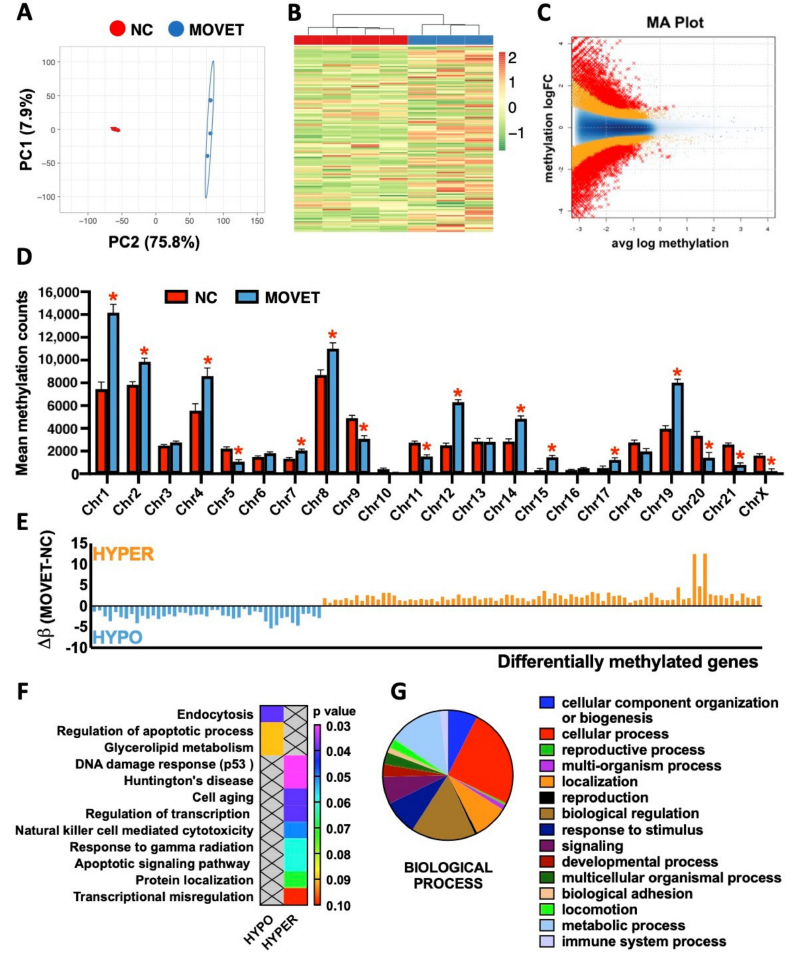
Figure 3. Genome-wide methylation changes in the liver of F3 generation animals derived from early embryos exposed to the combination of multiple ovulations, vitrification and embryo transfer (MOVET) and naturally conceived (NC) were compared. ( A ) Principal components analysis of